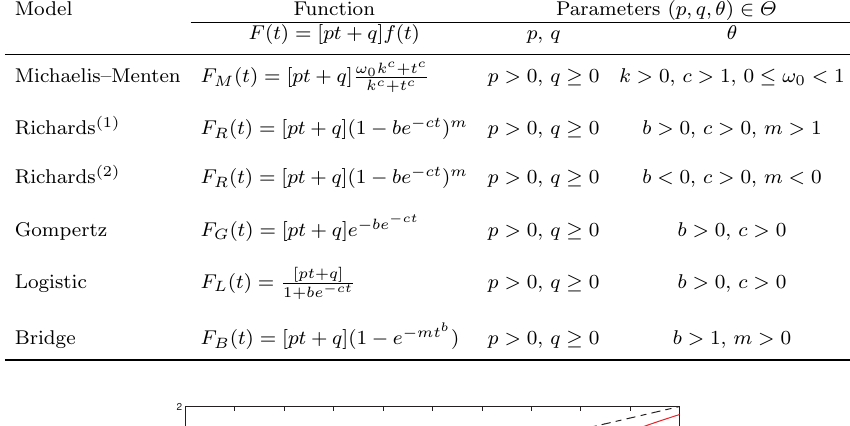
Table 2. Growth models with an oblique asymptote y = pt + q . Model